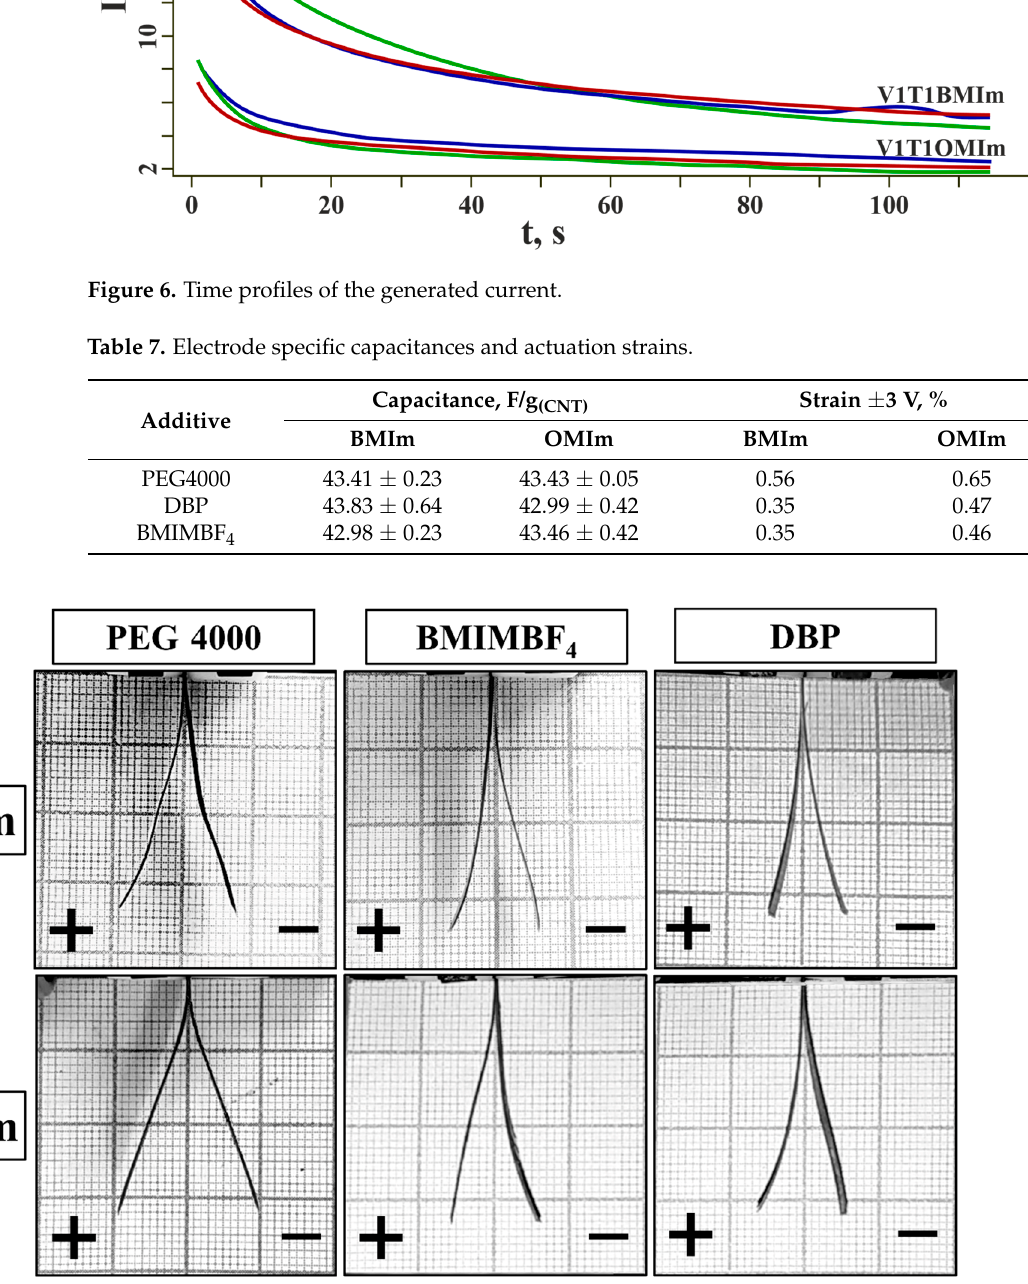
Figure 7. Peak-to-peak deformation.